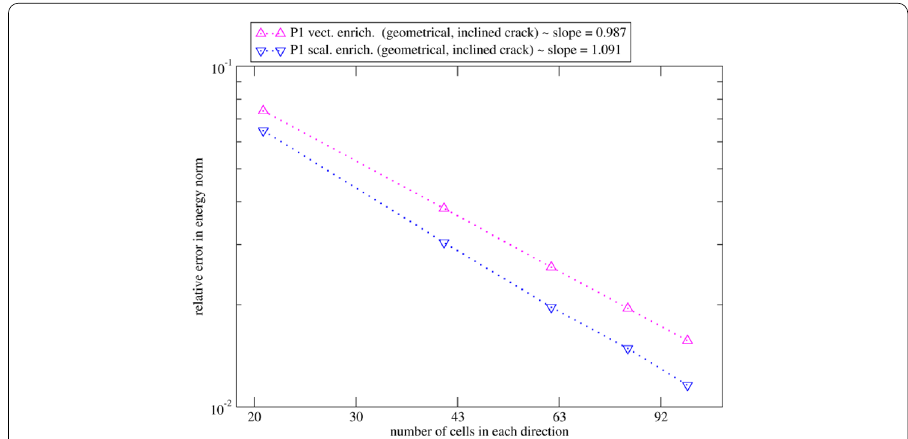
Fig. 26 Convergence analysis for vectorial and scalar enrichments with a crack orientation at 44 . 9 ◦ . Both enrichments have optimal convergence order but error levels are quite high. Results are in accordance with the ones of Fig. 22 and X-FEM is more accurate than